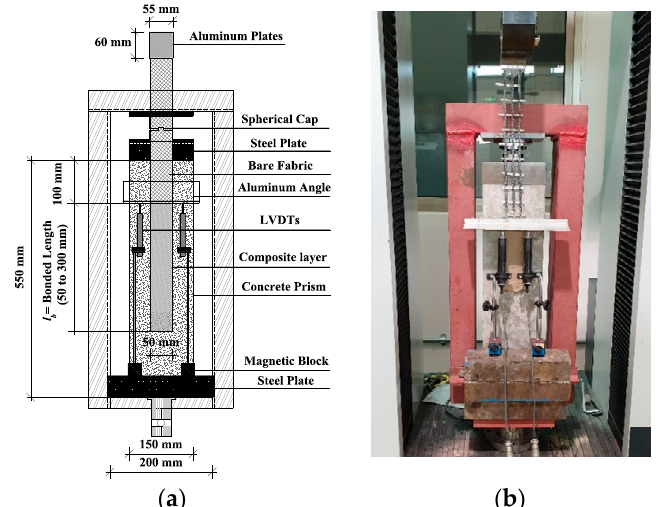
Figure 2. Bond test: ( a ) A schematic of the test specimen and set-up; ( b ) A test in